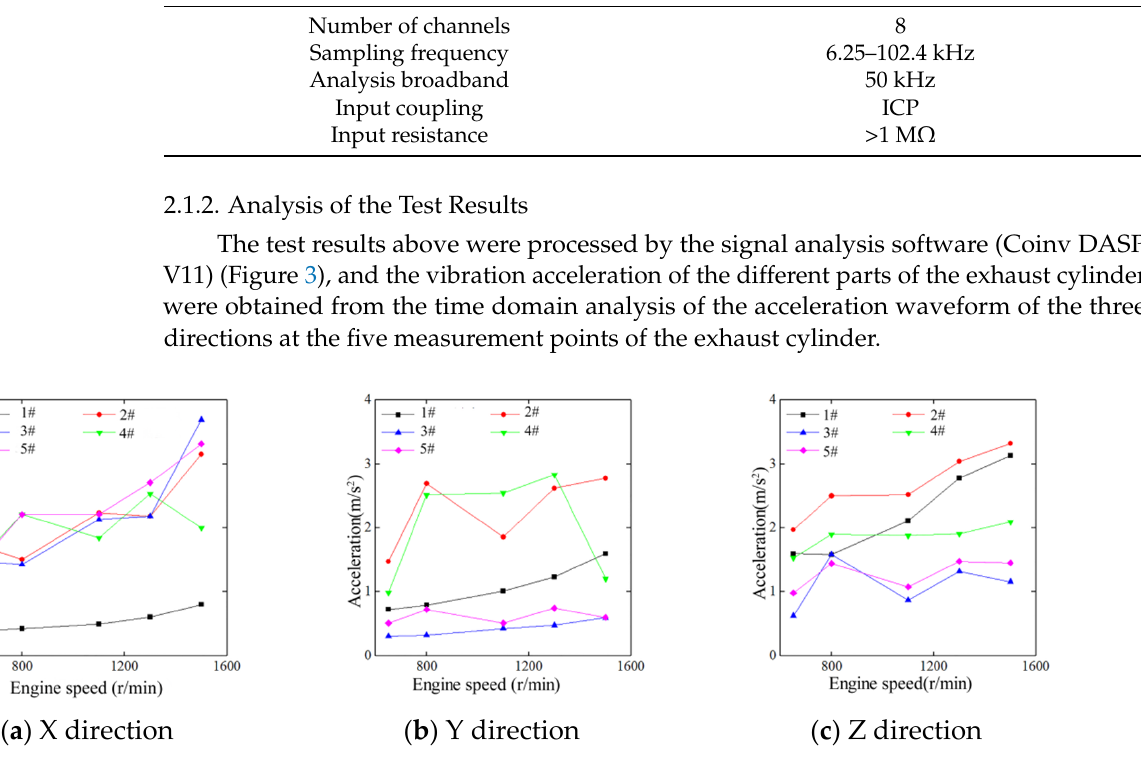
Figure 3. Comparison of the time domain analysis results of the exhaust cylinder vibration,where 1# is the NO.1point in Table 1. And so on.